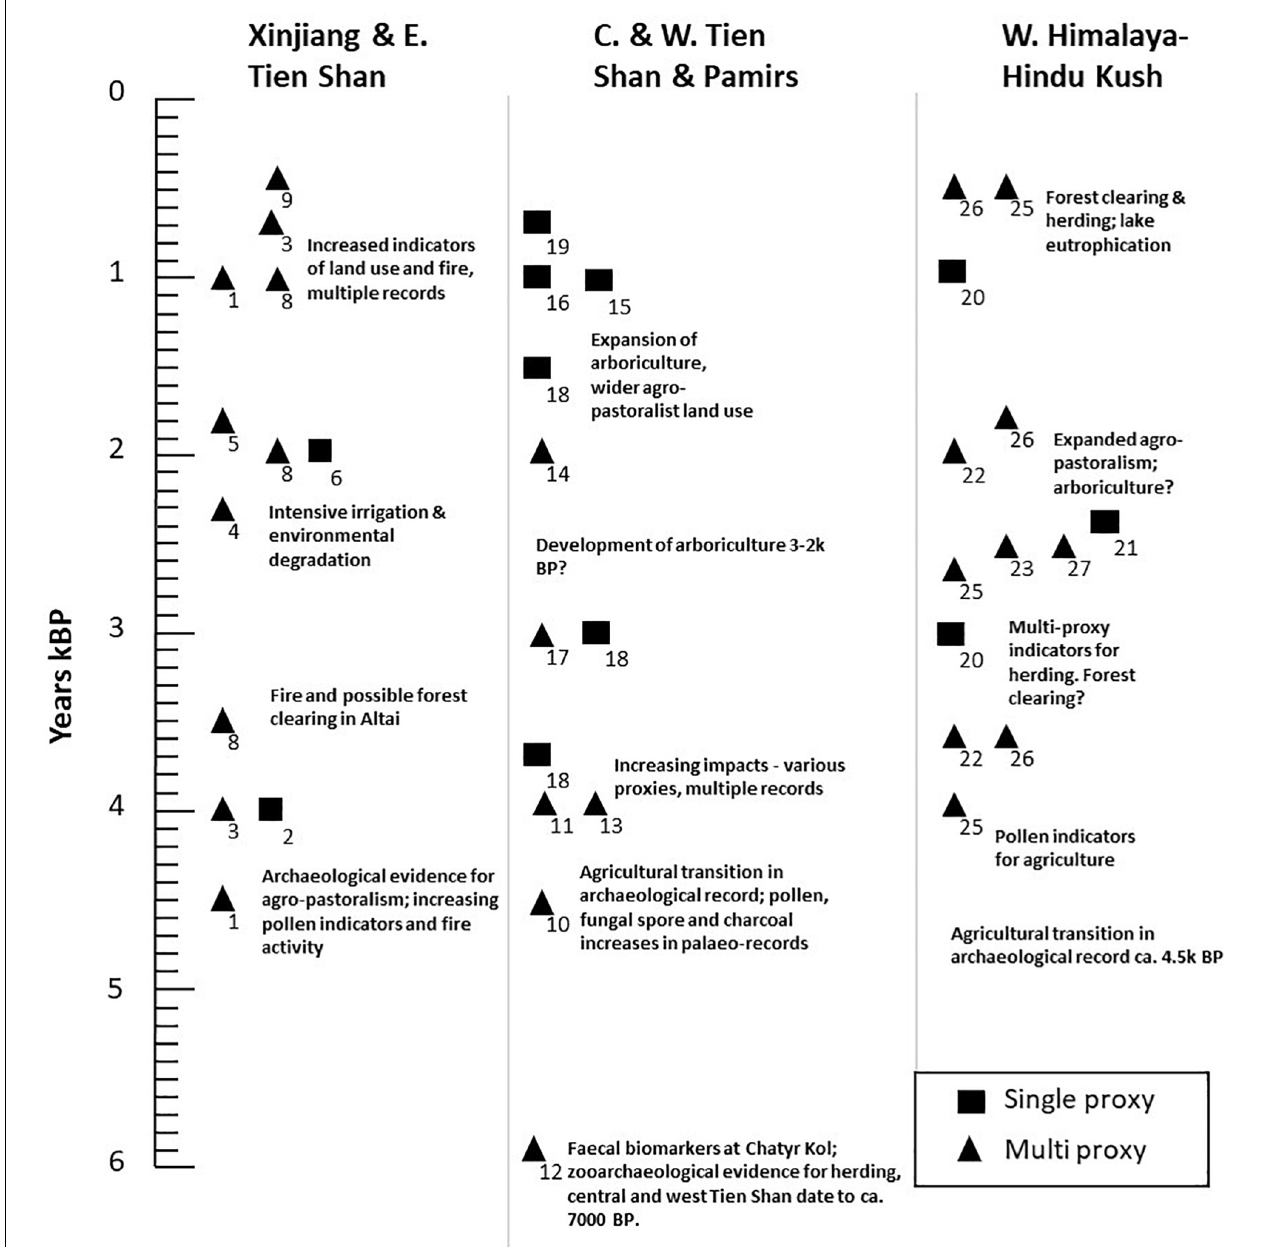
FIGURE 4 | The time scale of impacts identified in the studies reviewed here and described changes from available archaeological and environmental records. Numbers refer to records in Table 1